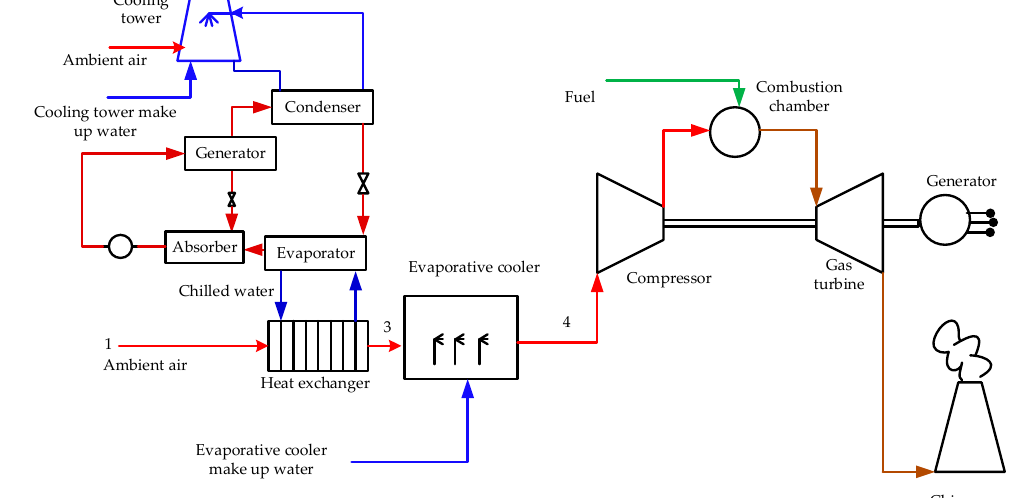
Figure 4. Gas turbine with evaporative-absorption refrigeration inlet cooling.